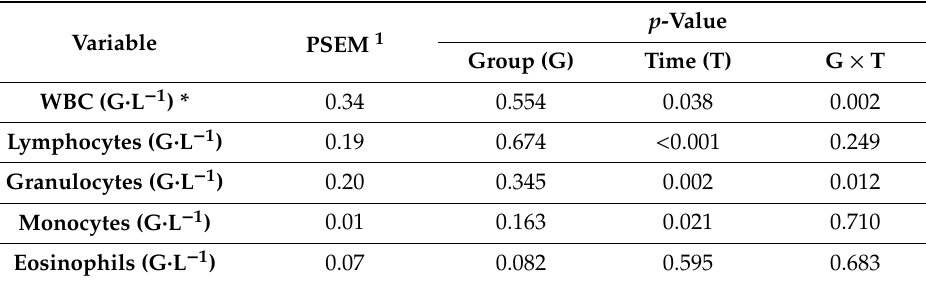
Table 4. Effect of a ration change from TMR to pasture on blood variables: haptoglobin, tryptophan (Trp) and kynurenine (Kyn).